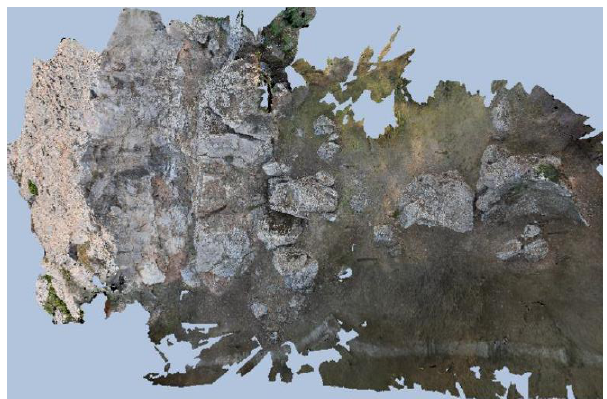
Figure 3: The textured 3d model of the Areopagus peak and the collapsed rock masses.